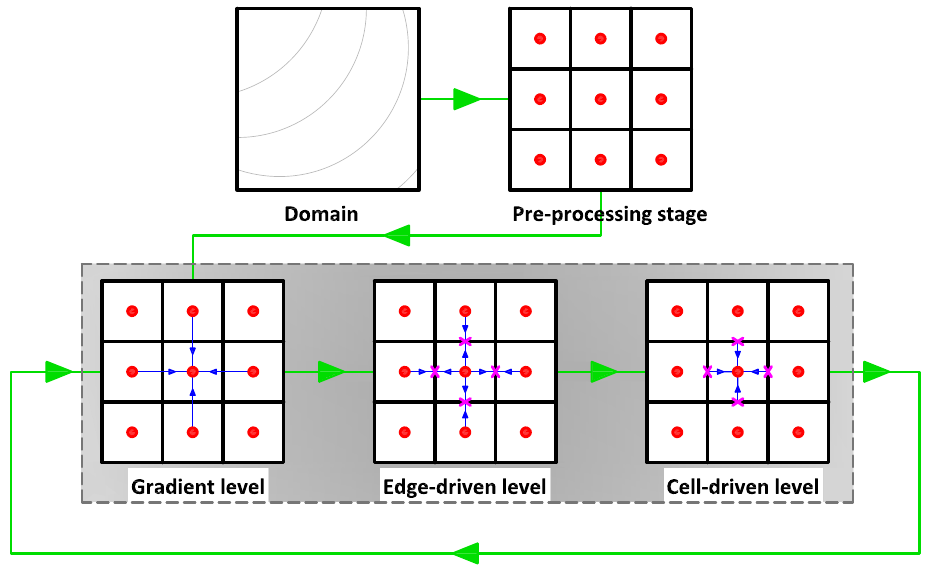
Figure 1. Typical process in shallow flow modeling (with implementations of modern finite volume